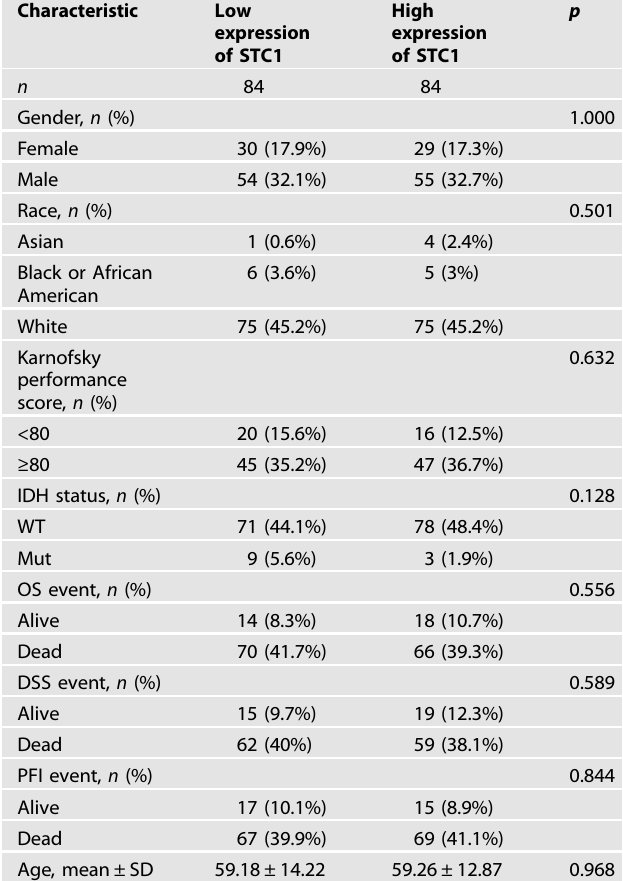
Table 3. Correlation between STC1 expression and clinicopathologic characteristics of GBM